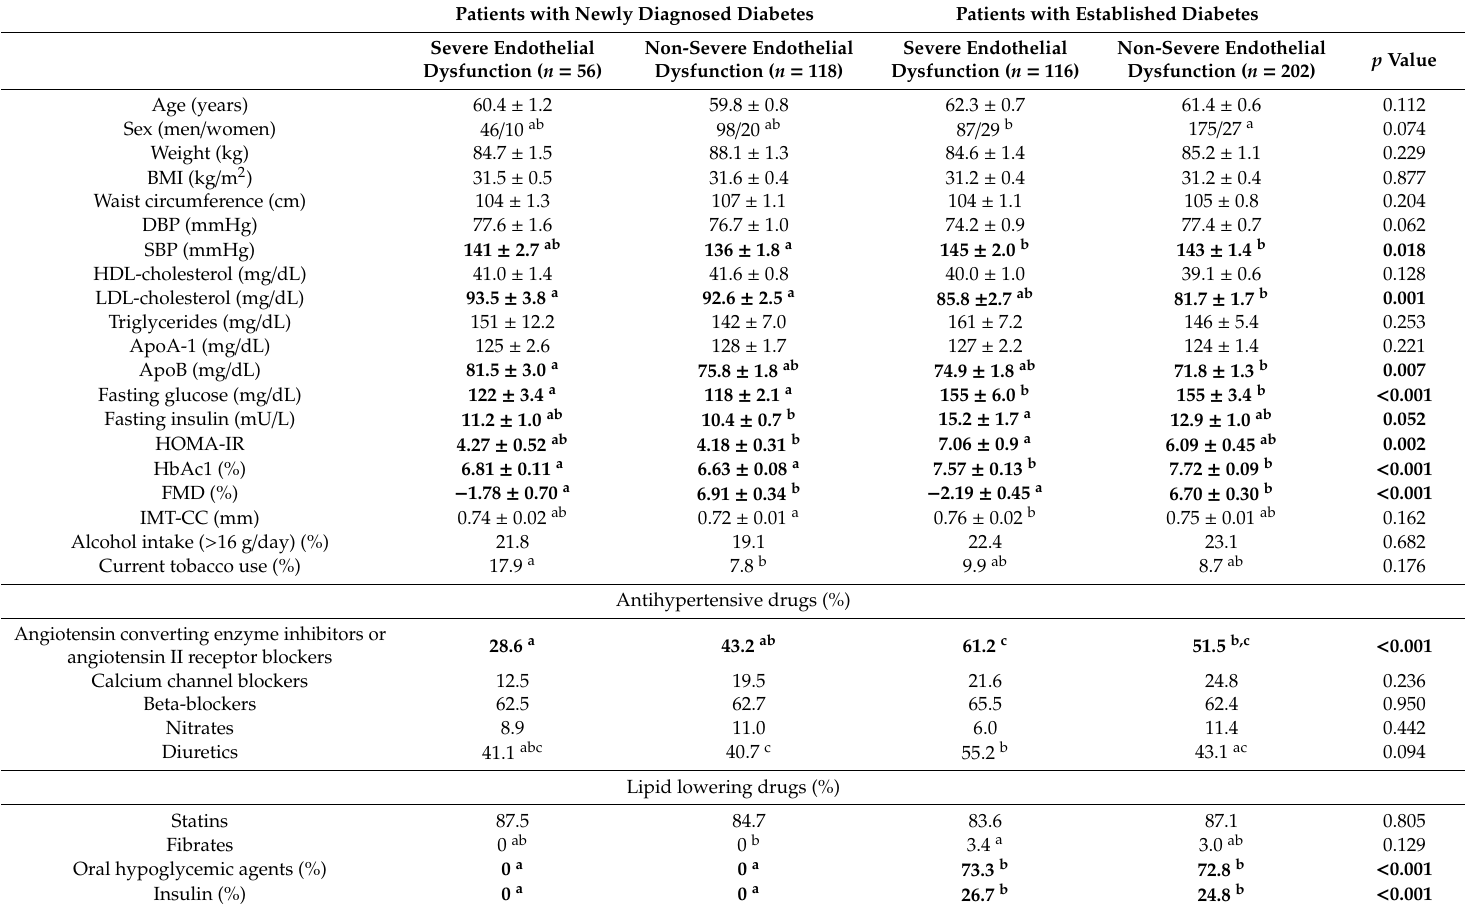
Table 2. Characteristics of the study groups considering the severity of endothelial dysfunction 1